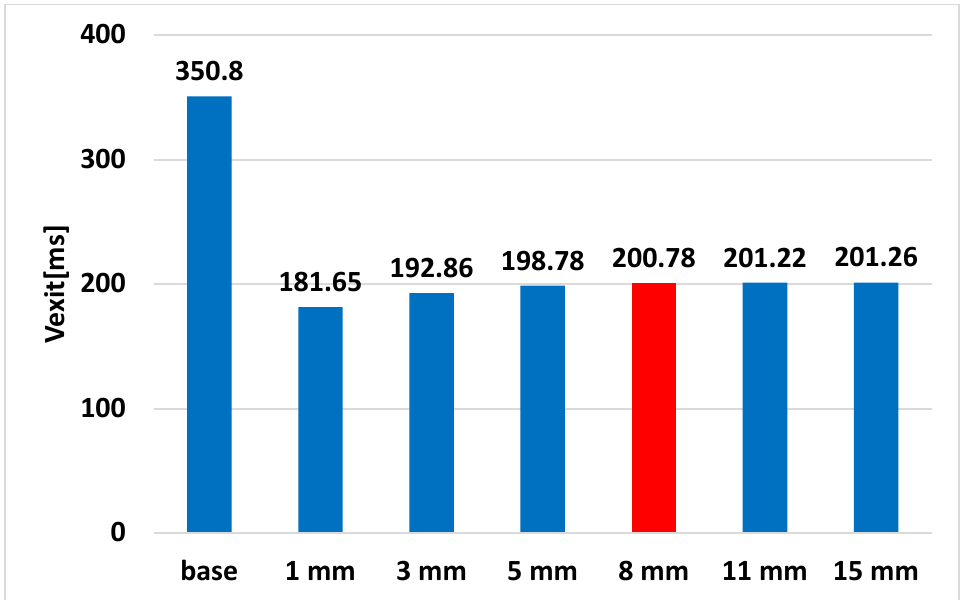
Figure 15. The variation of the exhaust velocity of the gases read in section 3 obtained in the numerical simulations for the variation of section 5.